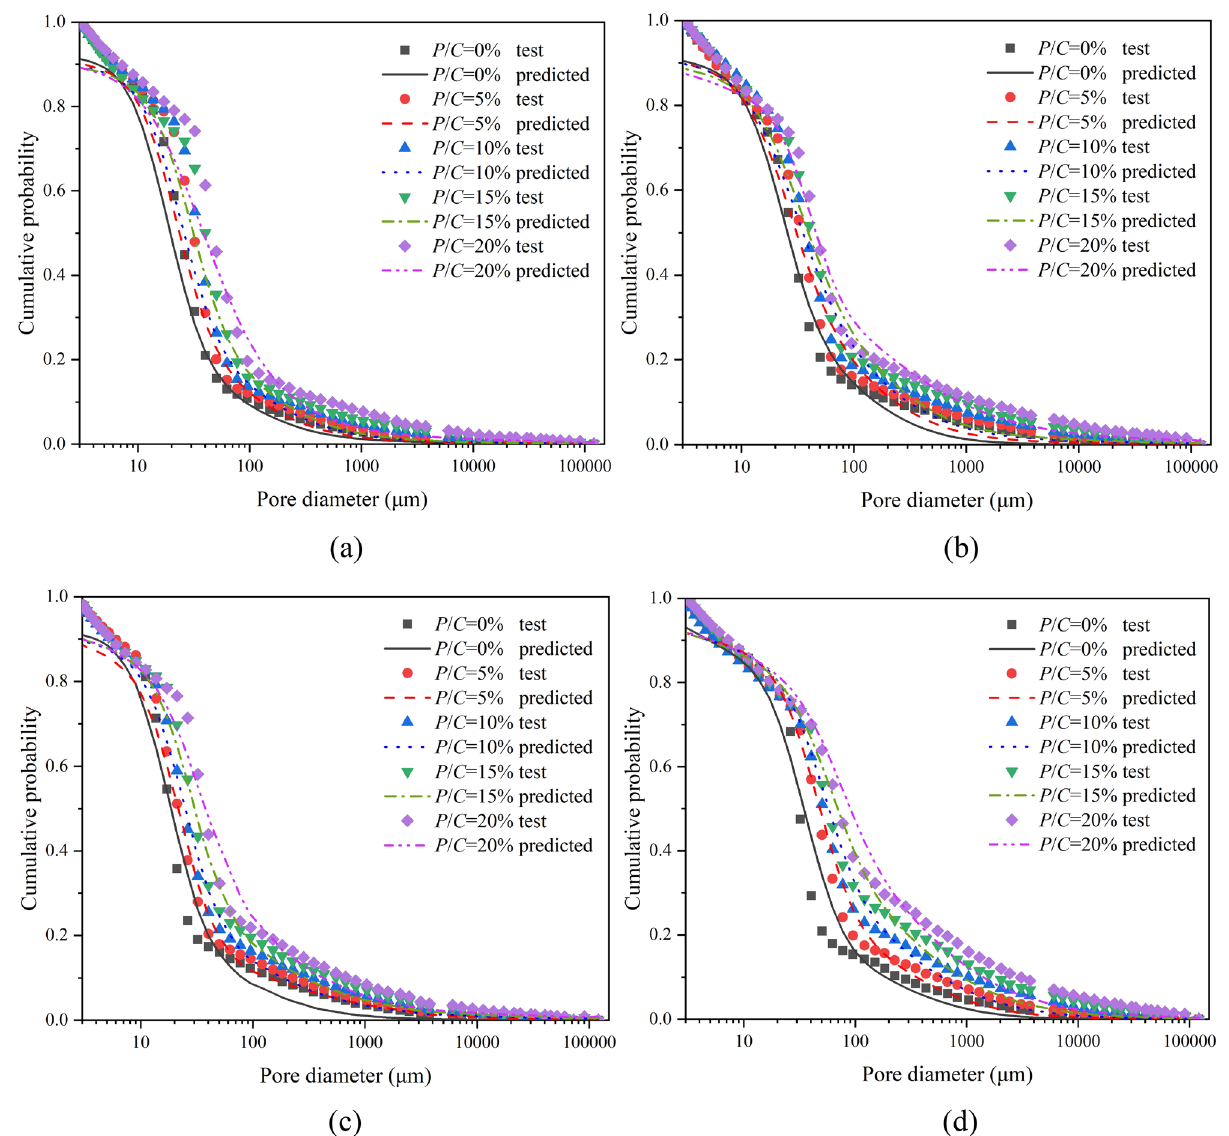
Figure 9. Relationships between predicted and tested cumulative pore size distributions of epoxy latex- modified mortars at ( a ) 7, ( b ) 14, ( c ) 28, and ( d ) 90